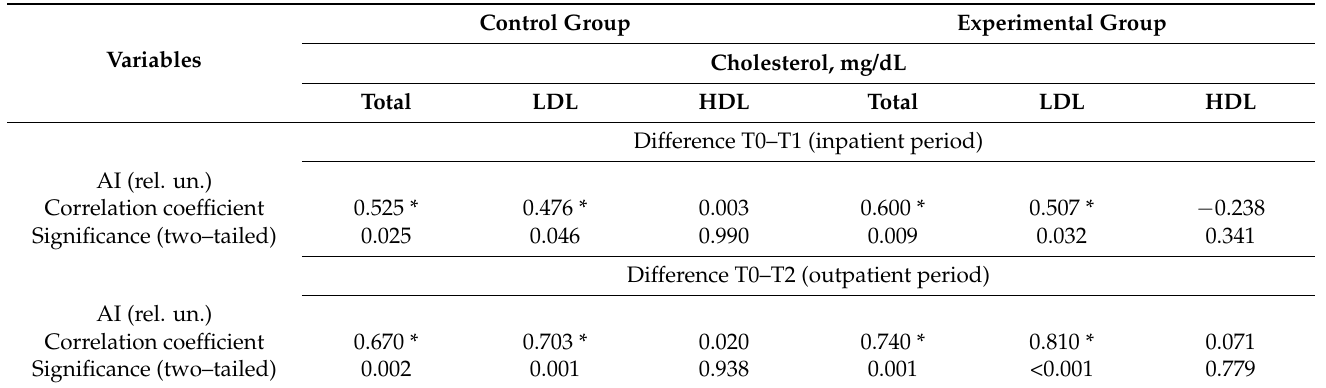
Table 7. Correlation between patients’ serum atherogenic index and cholesterol profiles during the trial. Control Variables